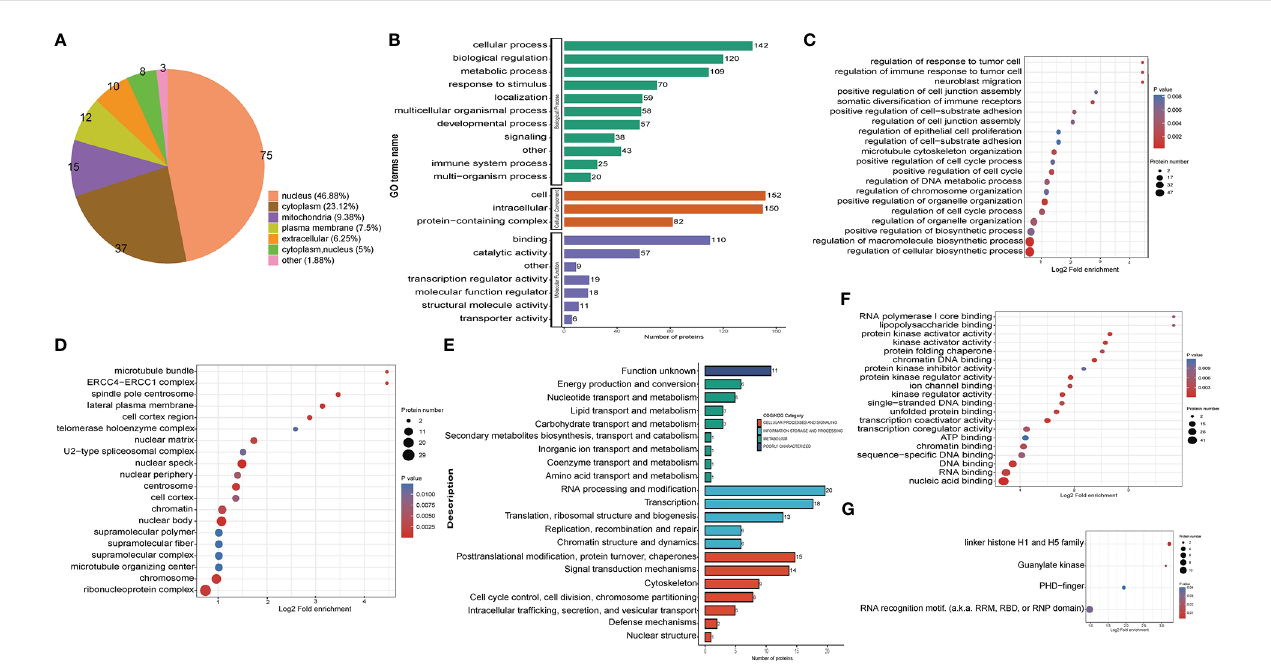
FIGURE 5 Functional classi fi cation of up-regulated crotonylated proteins in THP1 cells infected by MRSA for 3 hours then treated by vancomycin for 0.5 hours compare with control cells. (A) Pie chart of the percentage and number of up-regulated crotonylated protein. (B) Bar graphs showing GO-based enrichment analysis of the up-regulated crotonylated proteins. (C) Biological Process category analysis. (D) Cellular Component category analysis. (E) COG/KOG category analysis. (F) Molecular function analysis. (G) Up regulated